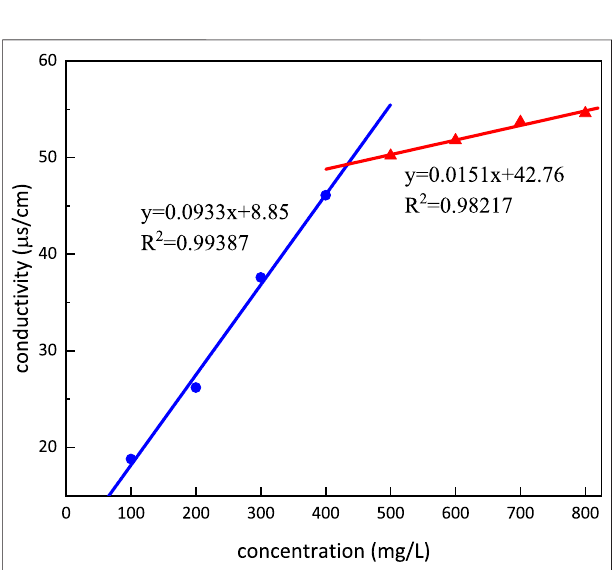
FIGURE 8 | Surface tension dependence on the concentration of m -HPAE. FIGURE 9| Conductivity dependence on the concentration of m